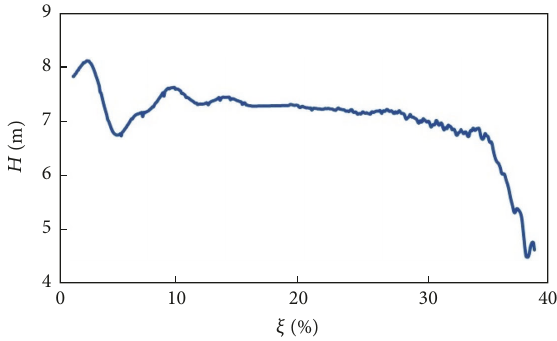
Figure 9: Change of 𝐻 with 𝜉